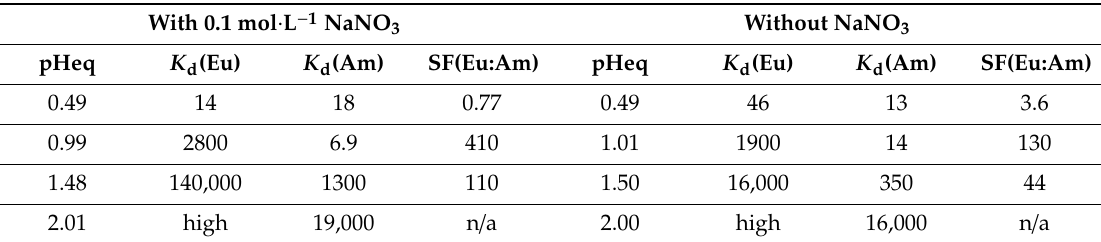
Table 1. Distribution coe ffi cients ( K d ) and separation factors (SF) for semi-crystalline α -zirconium phosphate (ZrP) in binary solutions of Eu(III) and Am(III) in nitric acid with and without 0.1 mol · L − 1 NaNO 3 . SF = the ratio of K d (Eu) to K d